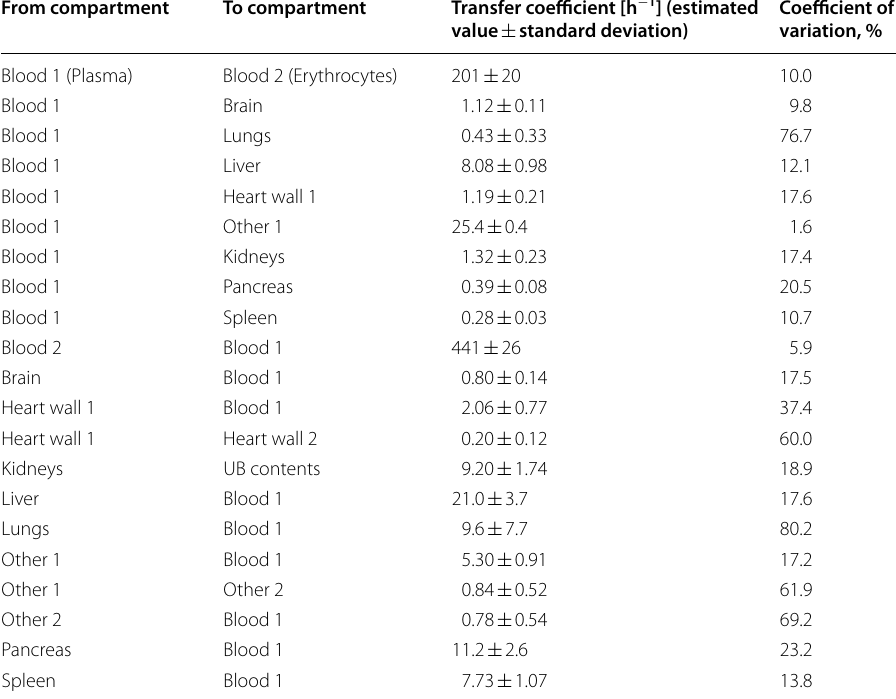
UB urinary bladder